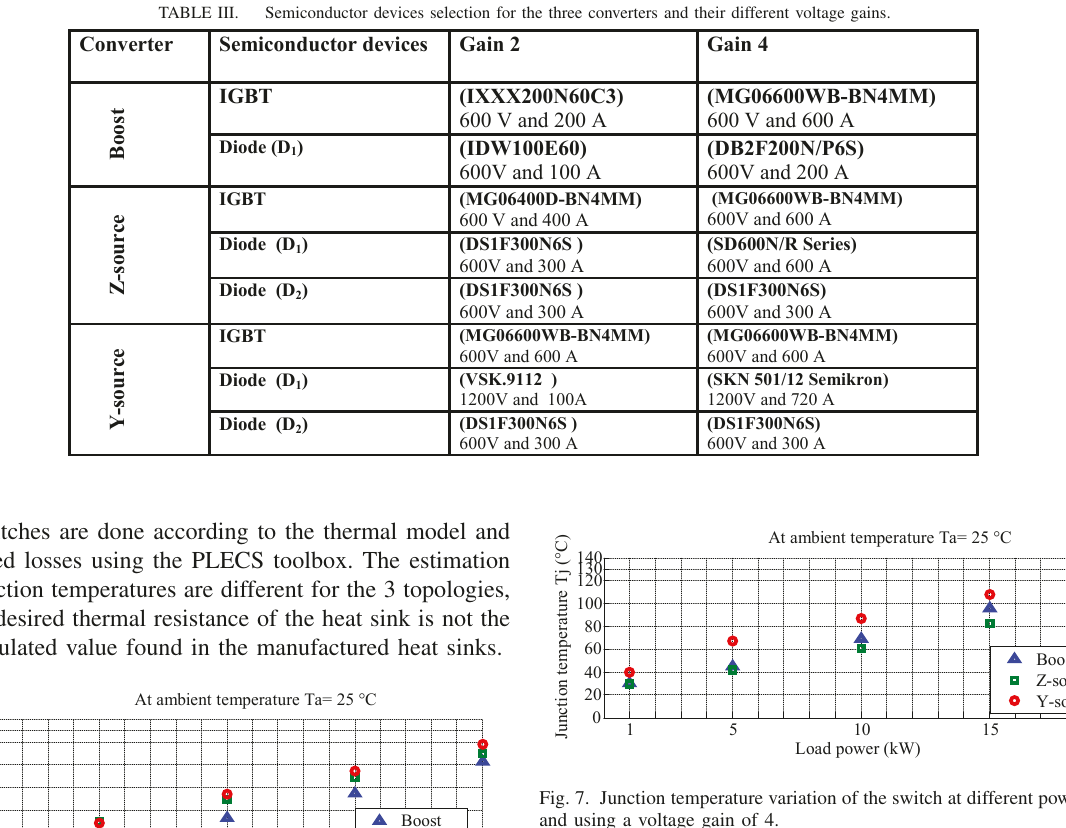
Maximum junction temperature T j-max.